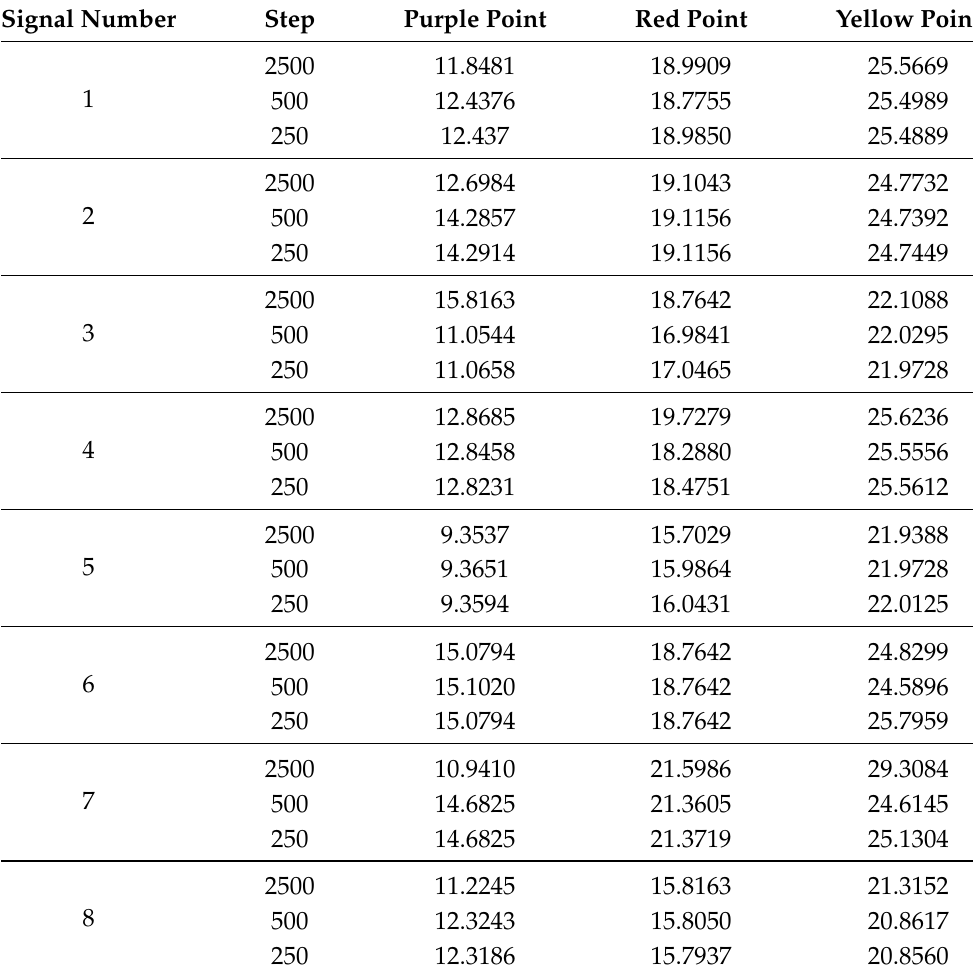
Table 1. Detected regime change points (in seconds) for all eight signals for different values of step at which the window of length 2500 is